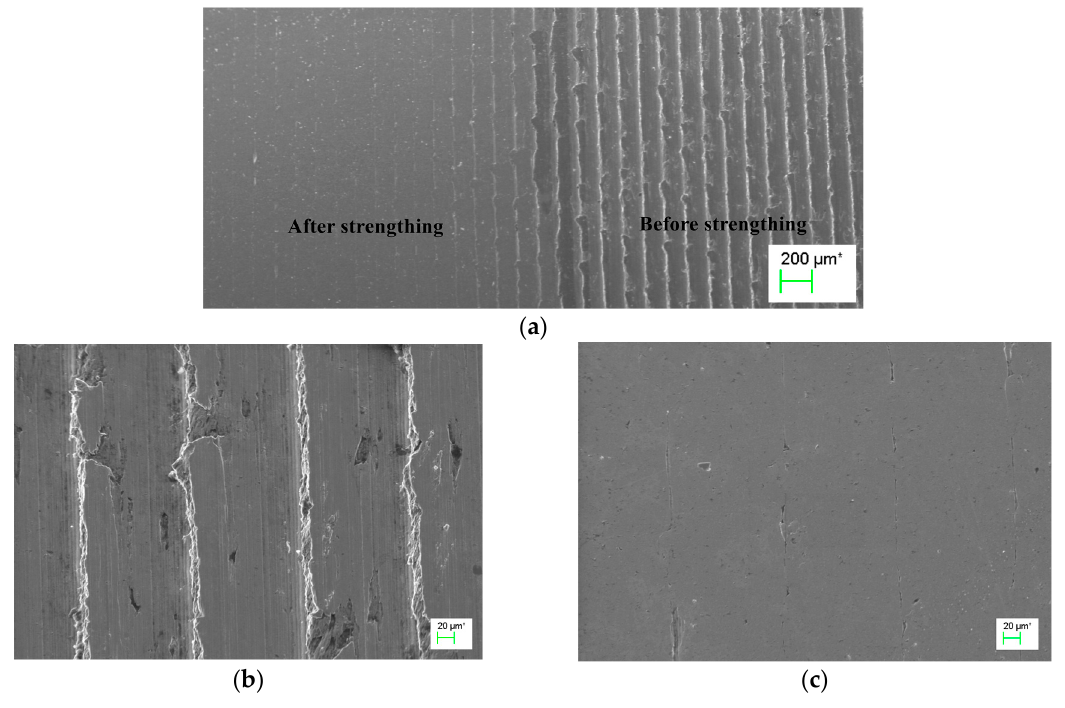
Figure 7. Appearance contrast before and after ultrasonic surface strengthening. ( a ) Appearance contrast before and after strengthening (20×); ( b ) Before strengthing (200×); ( c ) After strengthing (200×).